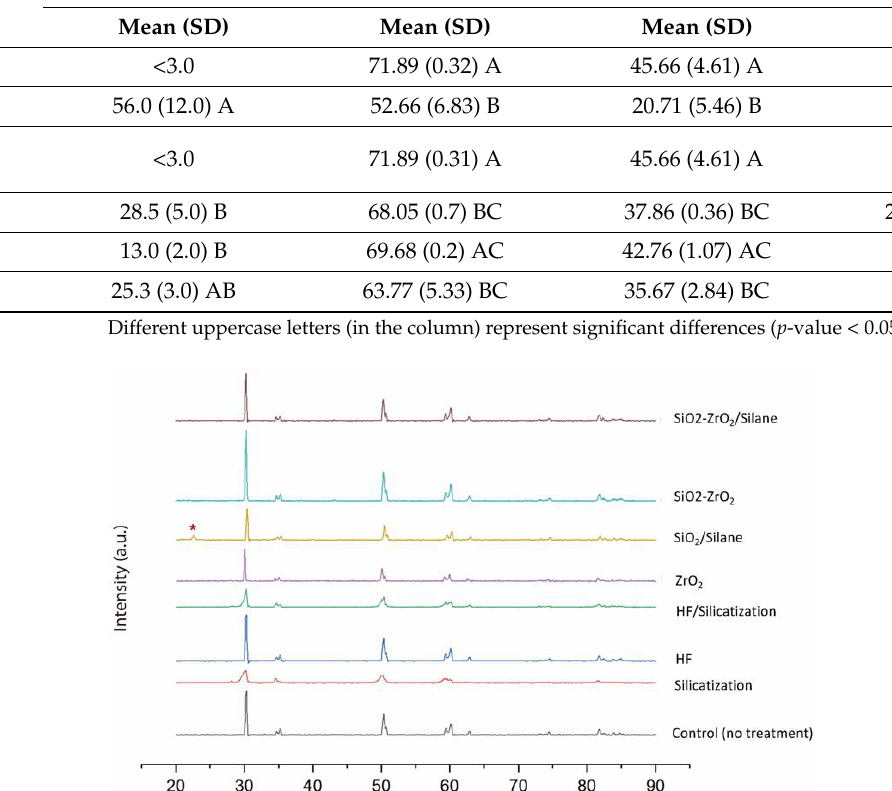
Figure 2. X-ray diffraction patterns for Y-TZP disks before and after different treatments. Untreated and coated disks with ZrO 2 film have the same diffraction characteristics. Red * indicated the presence of crystalline SiO 2 at the surface.